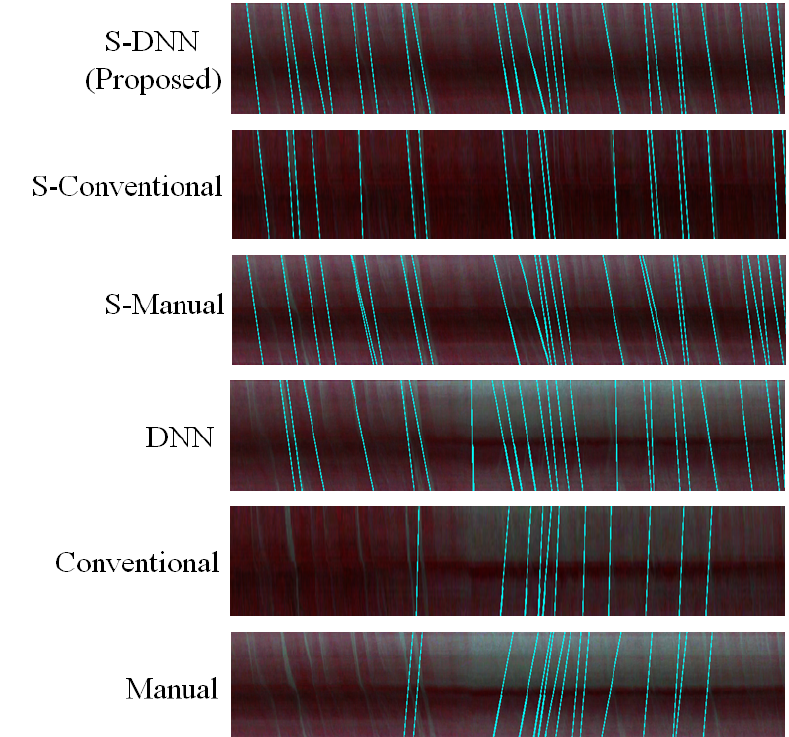
Figure A3. Events reconstructed from event counting using various methods for capillary 3.